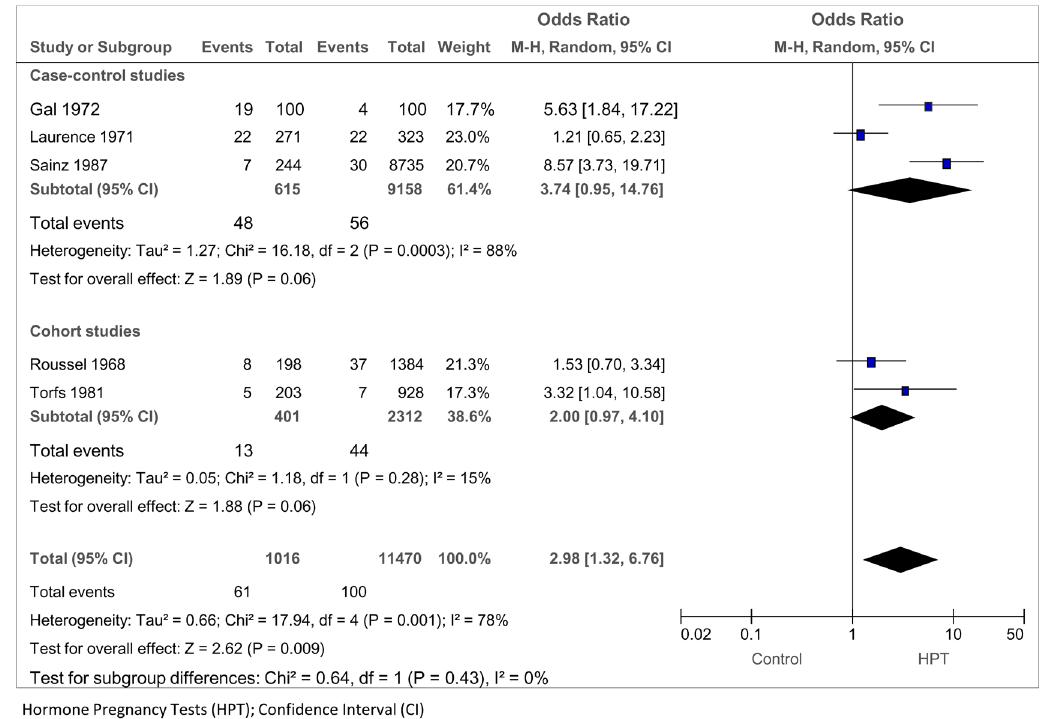
Figure 4. Association of exposure to oral hormone pregnancy tests (HPTs) in pregnancy and nervous system malformations in the